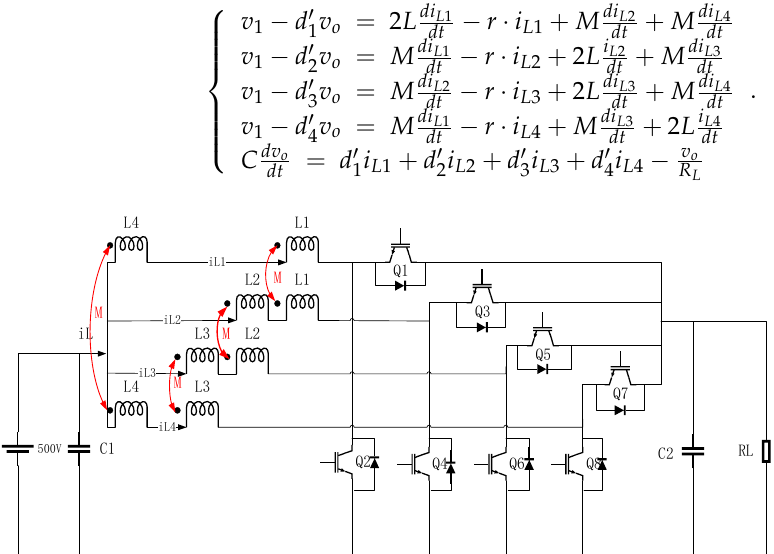
Figure 1. Four-phase interleaved parallel bidirectional converter.